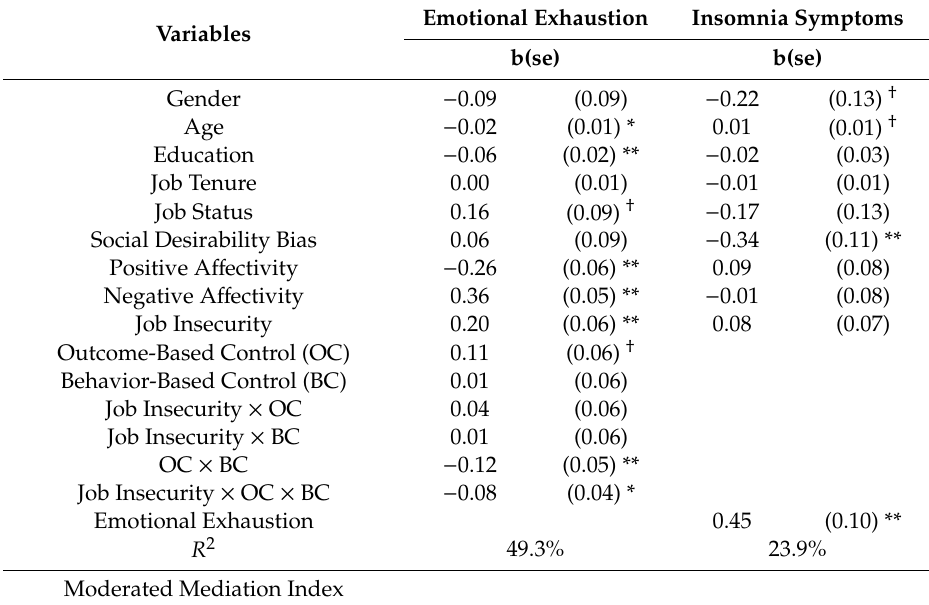
Table 4. Test of the moderating e ff ects of outcome-based and behavior-based controls.